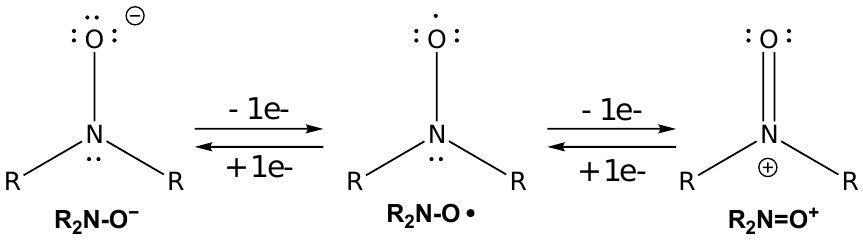
Figure 1. The nitroxide functional group across three oxidation states.